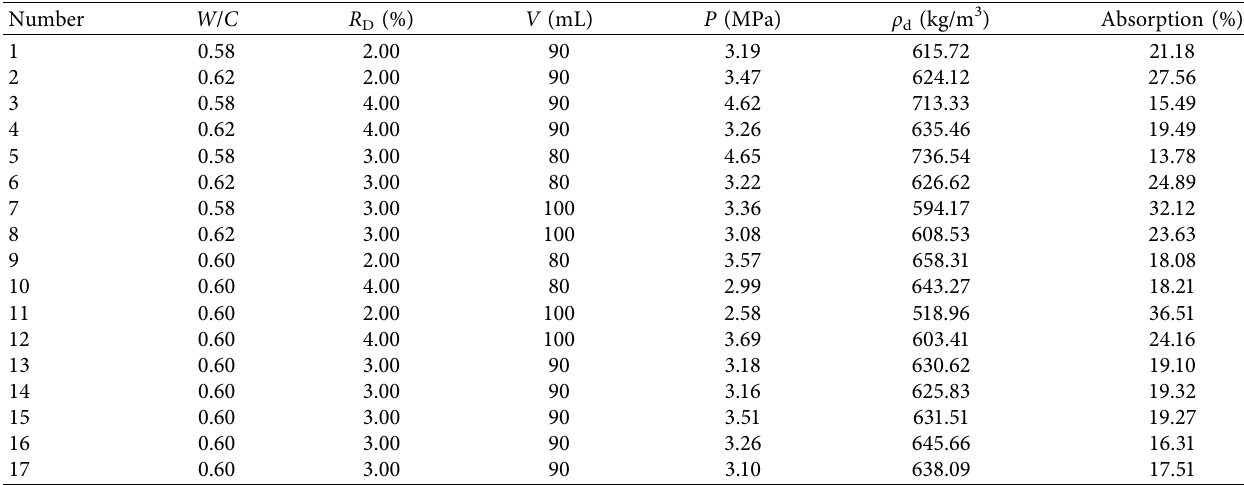
Figure 20: SEM images of foamed concrete under different diatomite contents: (a) 0; (b) 1%; (c) 2%; (d) 3%; (e) 4%; (f) 5%; (g) 6%. Table 6: The response surface analysis of compressive